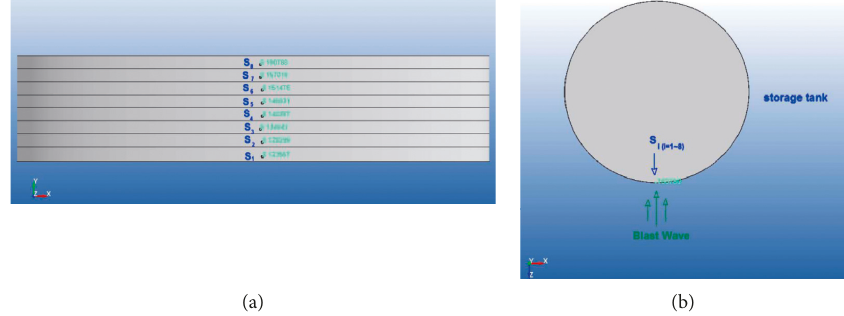
Figure 11: The distribution of measuring points S